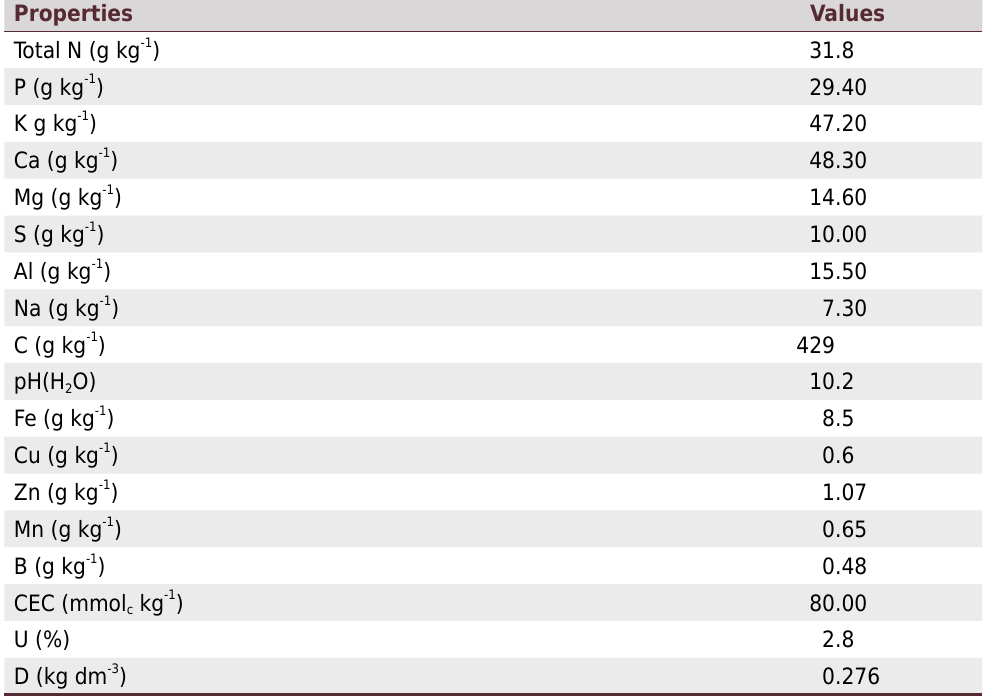
Table 1. Chemical characterization of the biochar used in the experiment Properties